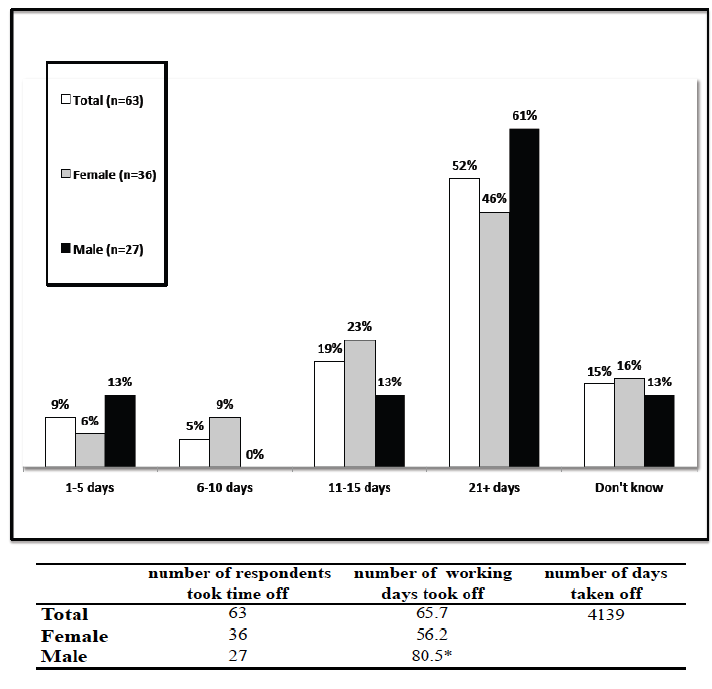
Figure 2. Average number of days taken off work because of depressive symptoms, all workers who taken off work ( n = 63) and by